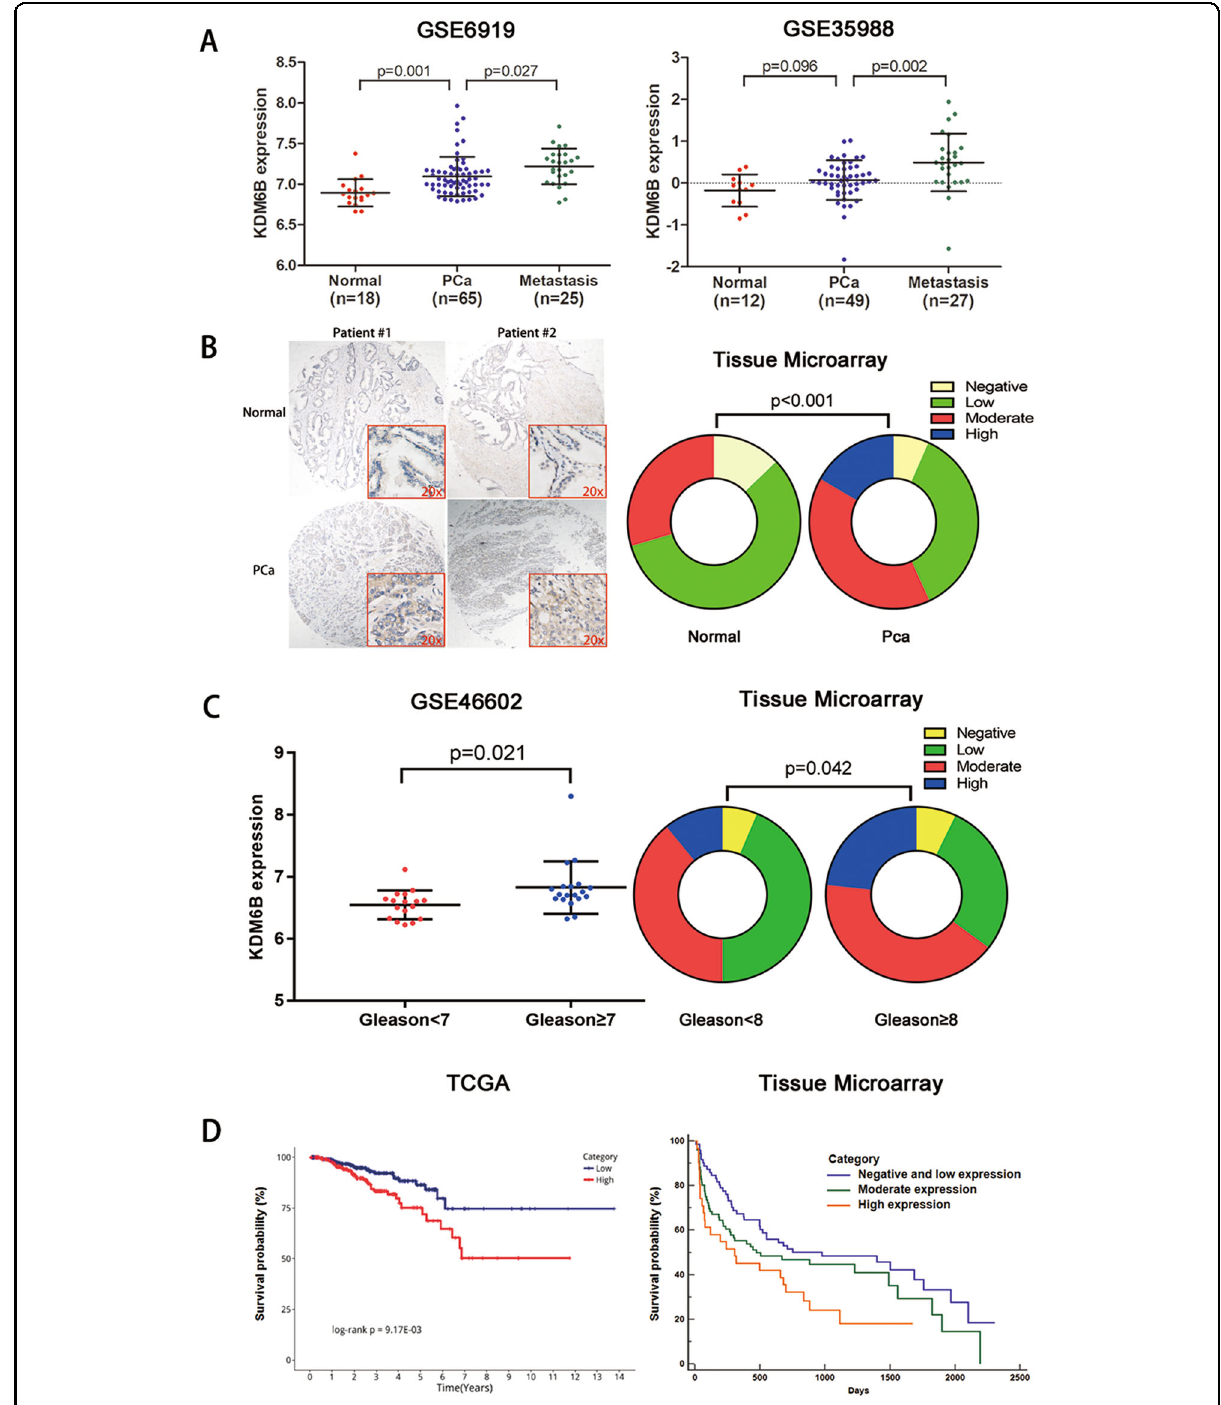
Fig. 1 KDM6B identi fi cation and clinical relevance. A Public database indicates the differentiated expression of KDM6B mRNA among normal prostate tissue, prostate cancer tissue, and metastatic cancer tissue. B Tissue microarray data indicates elevated expression of KDM6B protein prostate cancer tissue. C The elevated KDM6B mRNA and protein expression levels in patients with a high Gleason Score are shown. D A Kaplan – Meier analysis of recurrence-free survival (mRNA, TCGA) and biochemical recurrence-free survival (protein, tissue microarray) in prostate cancer patients with differentiated KDM6B expression was performed (Note: Pca, prostate cancer; CRPC, castration-resistant prostate cancer. Gene expression data are presented as mean ± SD. Tissue microarray data are presented as percentage and detailed numbers of each degree are listed in Supplemental Tables.).